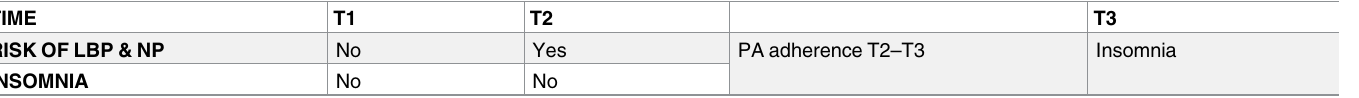
Table 3. Model 3: Examining the effect of PA adherence on subjects with LBP/NP risk profiles that did not report pain at T1, on the risk of develop- ing insomnia (n = 85). TIME T1 T2 T3 RISK OF LBP & NP No Yes PA adherence T2–T3 Insomnia INSOMNIA No